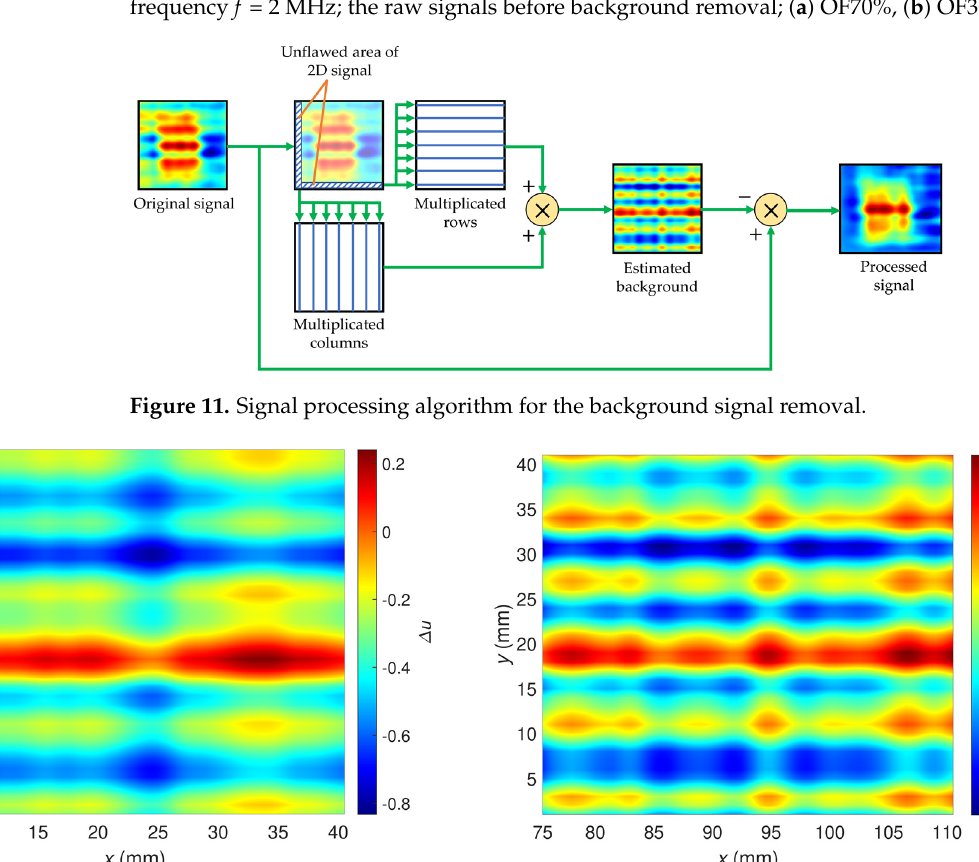
Figure 10. Two-dimensional plots of the relative voltage as a function of sensor position; excitation frequency f = 2 MHz; the raw signals before background removal; ( a ) OF70%, ( b ) OF30%.